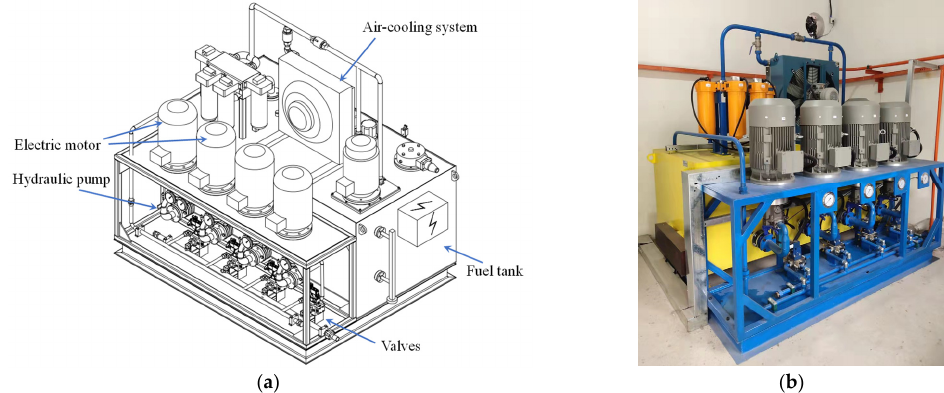
Figure 10. The hydraulic power units: ( a ) schematic illustration and ( b ) constructed assembly.